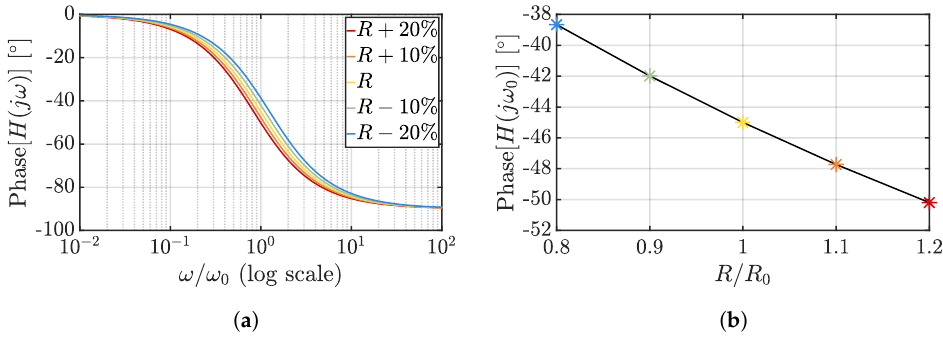
Figure 7. Phase dependency on resistance variations for an RC filter: impact on the phase response of the filter ( a ) and phase shift at ω 0 as a function of the resistance variation ( b ).